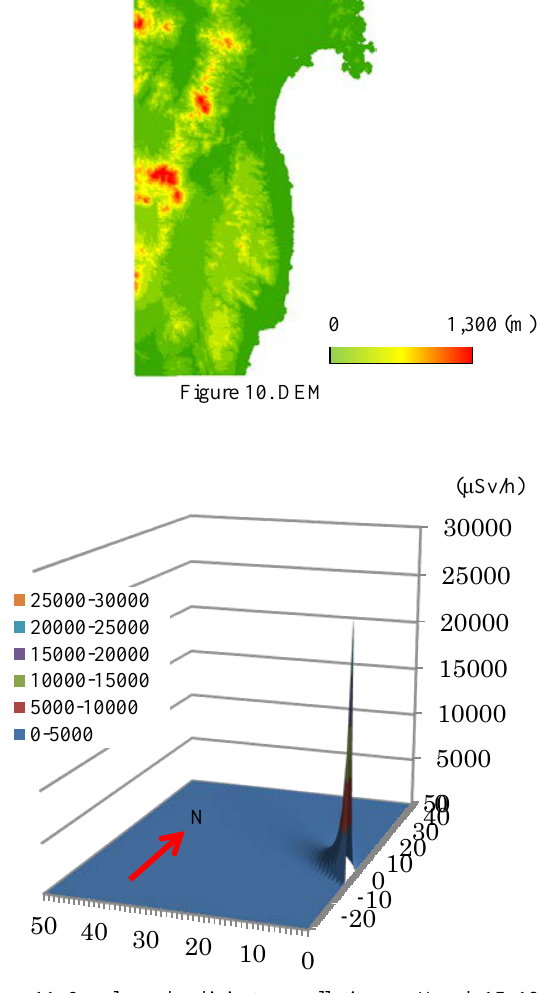
Figure 11. Overlapped radioisotope pollutions on March 15, 18 and 20.